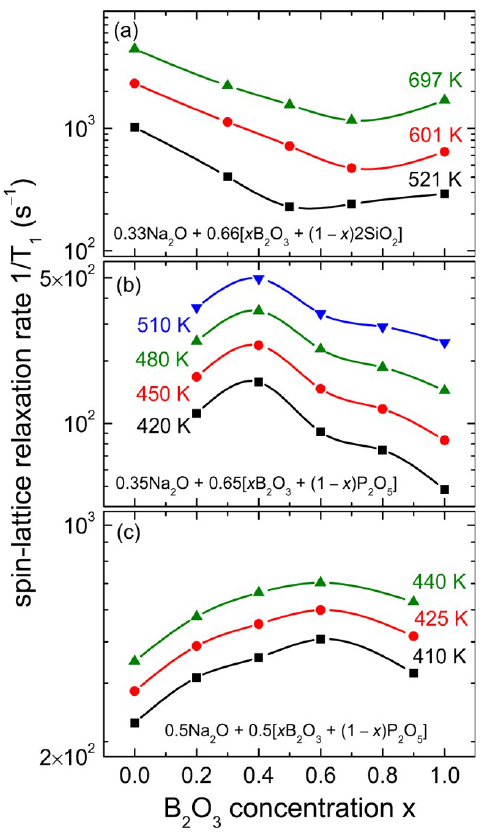
Figure 6. 23 Na Relaxation data as a function of Boron concentration in ( a ) borosilicate glasses and ( b , c ) various borophosphate glasses [21] .